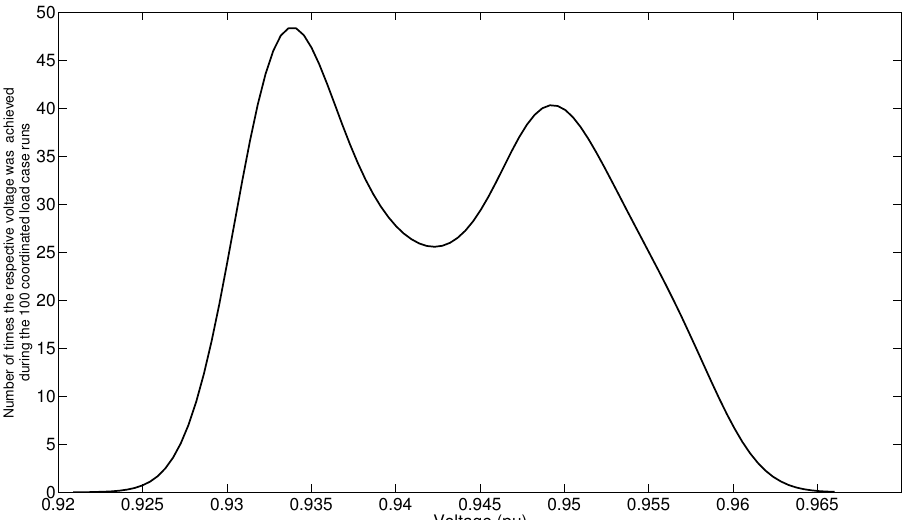
Figure 26. Probability density function of coordinated voltage on Node